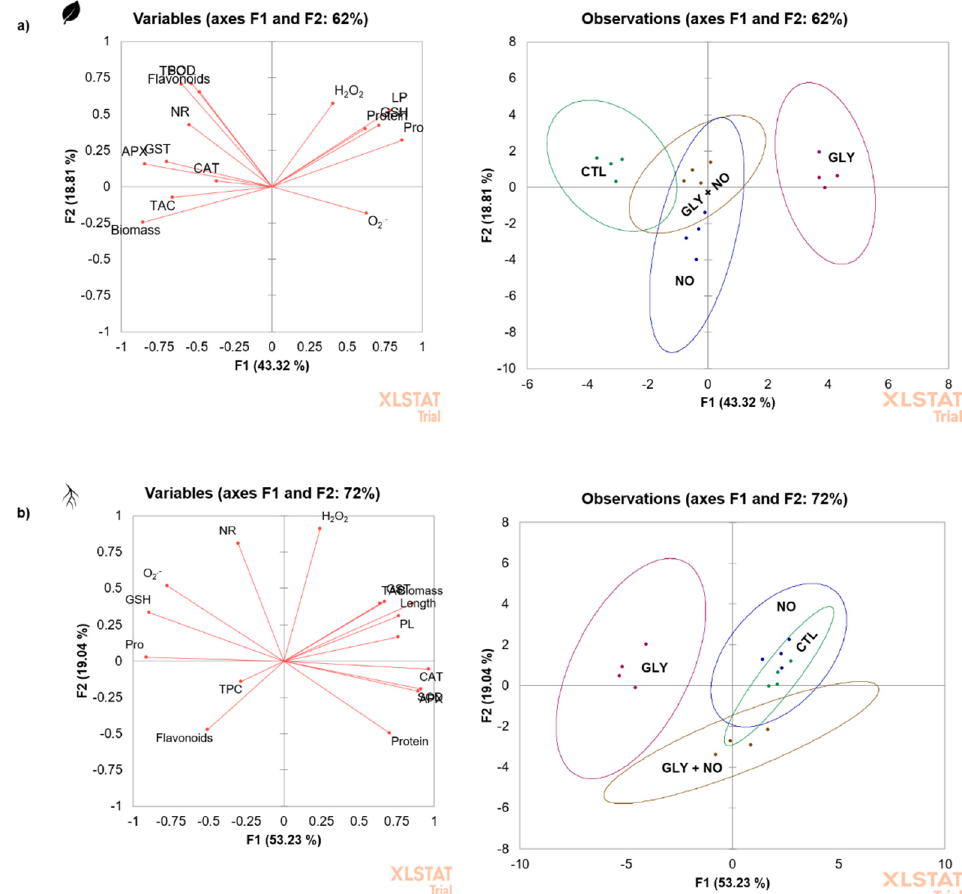
Figure 6. Principal component analysis (PCA) (xx axis—first component, yy axis—second component) of all evaluated endpoints (biometrical and biochemical) in ( a ) shoots and ( b ) roots of Solanum lycopersicum L. cv. Micro-Tom grown for 28 days in an artificial soil contaminated by GLY (10 mg kg − 1 ) and/or foliar sprayed with SNP (200 µM). CTL—control plants, grown in the absence of GLY and foliar sprayed with dH 2 O once a week (green points); NO—plants grown in the absence of GLY and foliar sprayed with SNP once a week (blue points); GLY—plants grown in the presence of GLY (purple points); GLY + NO—plants grown in the presence of GLY and weekly sprayed with SNP (brown points).